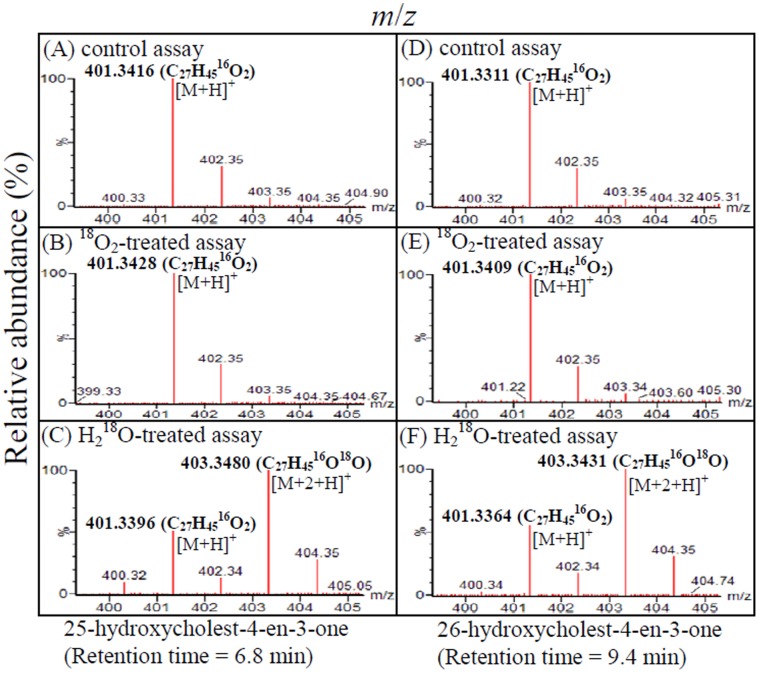
APCI-mass spectra (positive mode) of UPLC-separated 25-hydroxycholest-4-en-3-one (25-OH) and 26-hydroxycholest-4-en-3-one (26-OH).(A) 25-OH produced in the anoxic control assay. (B) 25-OH produced in the 18O2-treated assay. (C) 25-OH produced in the H2
18O-treated assay. (D) 26-OH produced in the anoxic control assay. (E) 26-OH produced in the 18O2-treated assay. (F) 26-OH produced in the H2
18O-treated assay.